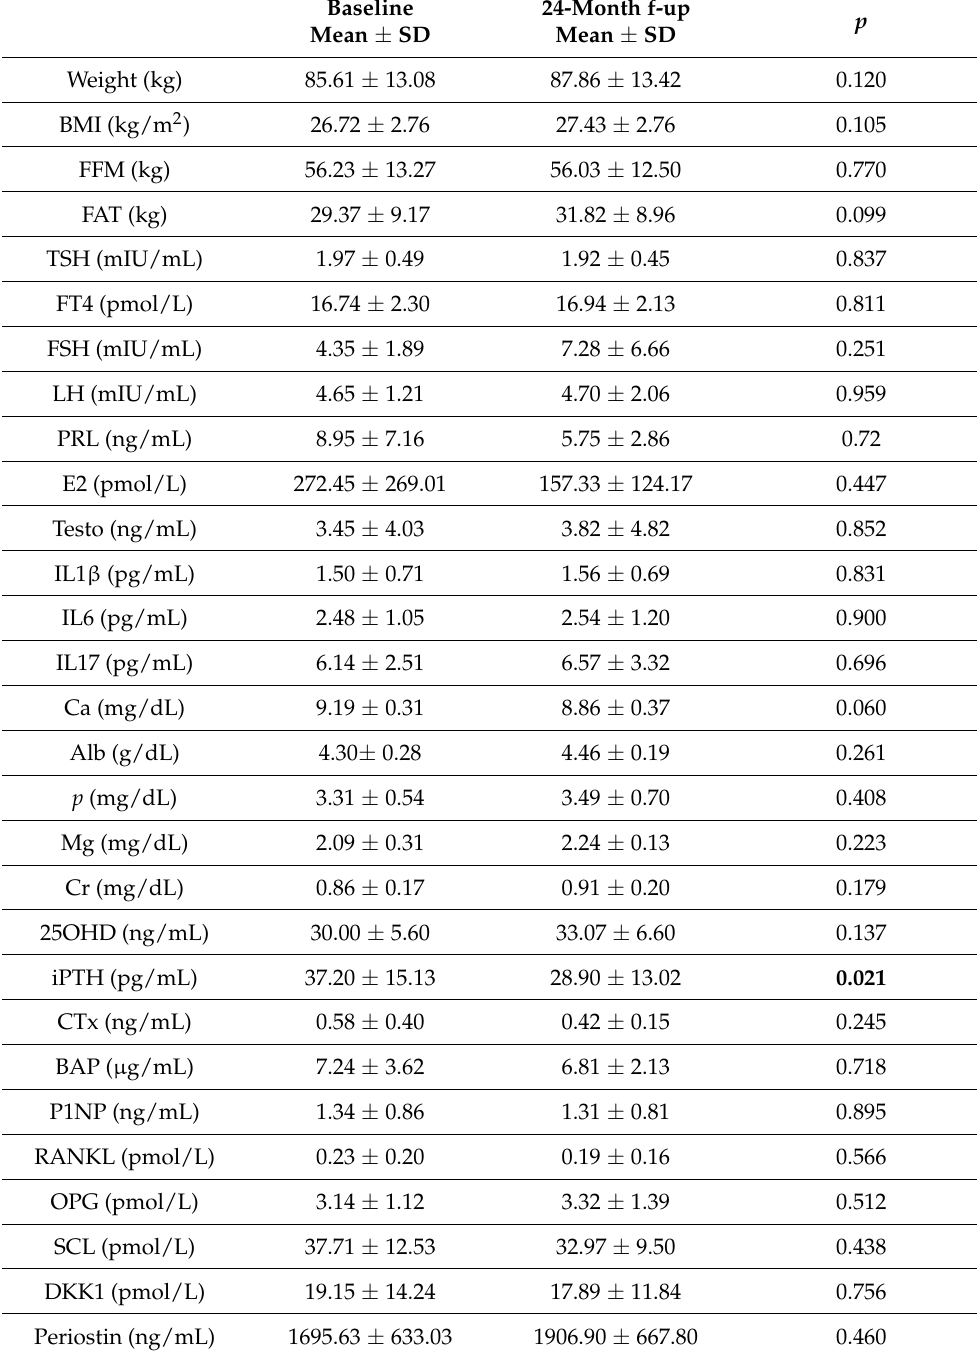
Table 1. Patients’ characteristics at baseline and after 24-months